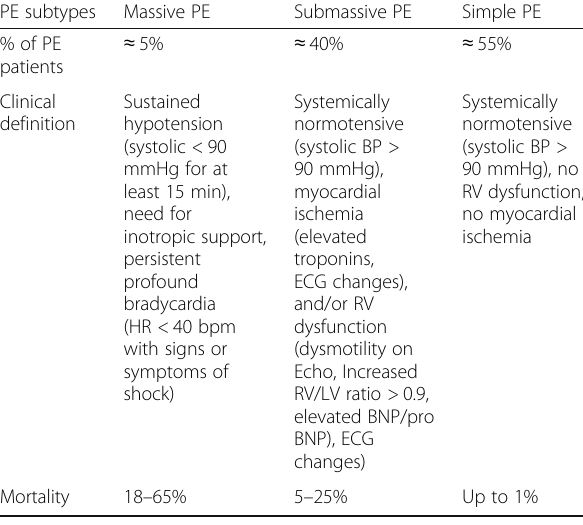
Table 1 PE subtypes, % of patients, clinical definition,